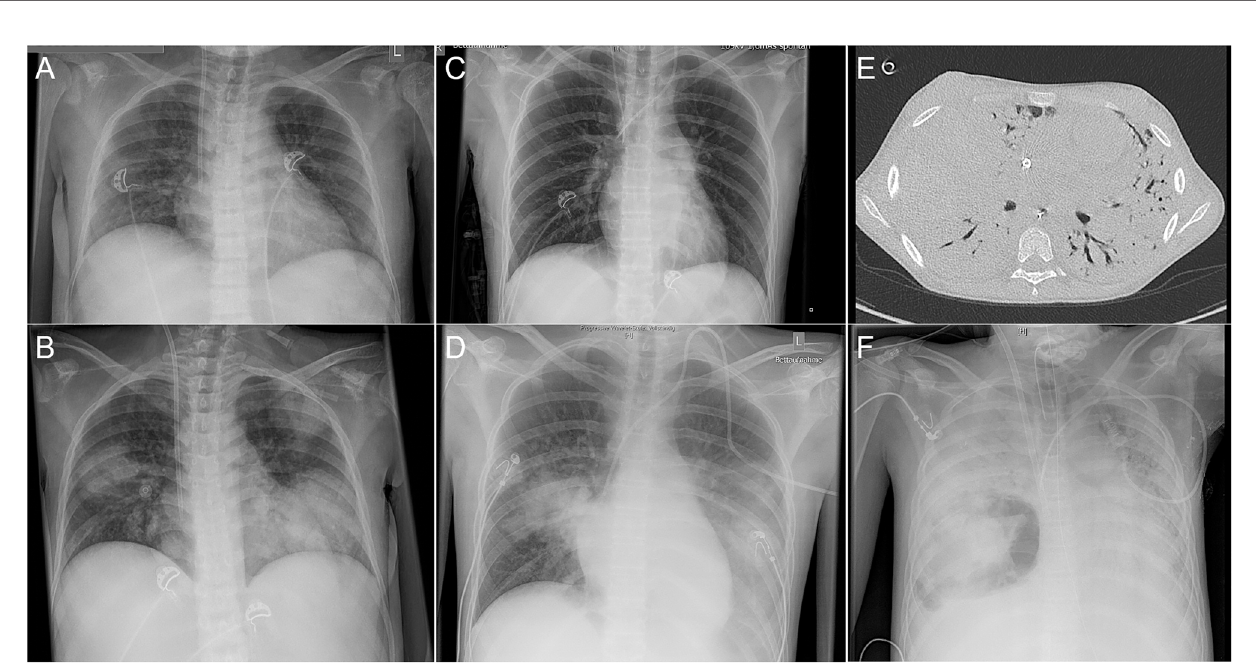
FIGURE 3 | Radiographic fi ndings in three patients with S.maltophilia infection and pulmonary hemorrhage. (A, B) 15-years old girl post allogeneic HCT for aplastic anemia (patient 4). (A) Normal chest x-ray at day +1 following allogeneic HCT; (B) S.maltophilia -related sepsis and ultimately fatal diffuse pulmonary hemorrhage at day +12 with detection of S.maltophilia in tracheal aspirates. (C, D) 17-years old male post allogeneic HCT for acute lymphoblastic leukemia (ALL) (patient 5). (C) Normal chest x-ray obtained during evaluation prior to transplantation; (D) S.maltophilia -related sepsis with ultimately fatal diffuse pulmonary hemorrhage on day +1 post-transplant. (E, F) 11-years old female with ALL (patient 3). First tracheal detection of S.maltophilia four days after microbiologically proven methicillin- susceptible Staphylococcus aureus pneumonia. (E) Middle lobe bleeding and atelectasis on chest CT-scans twenty-four days after fi rst S.maltophilia detection. (F) Intrapulmonary abscess thirty-one days after fi rst S.maltophilia detection; in the context of surgical resection, documentation of S.maltophilia from intraoperative tissue. Death forty- fi ve days after fi rst S.maltophilia